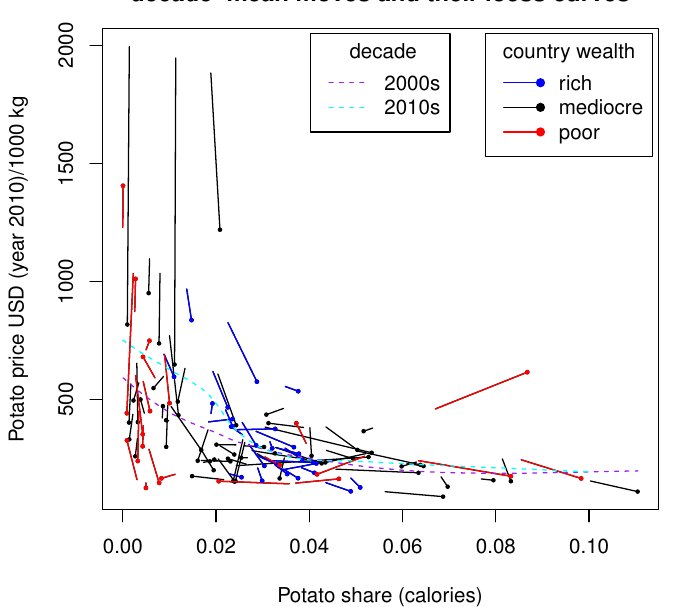
Figure 1. Potato consumption against price. Each country is represented by a half open line segment (pin), endpoints representing data values. The closed end (pinhead) of each connecting line is average for 2000–2009. The open end (without pinhead) is average for 2010–2019. The segments (pins) are colored here by three classes of GDP per